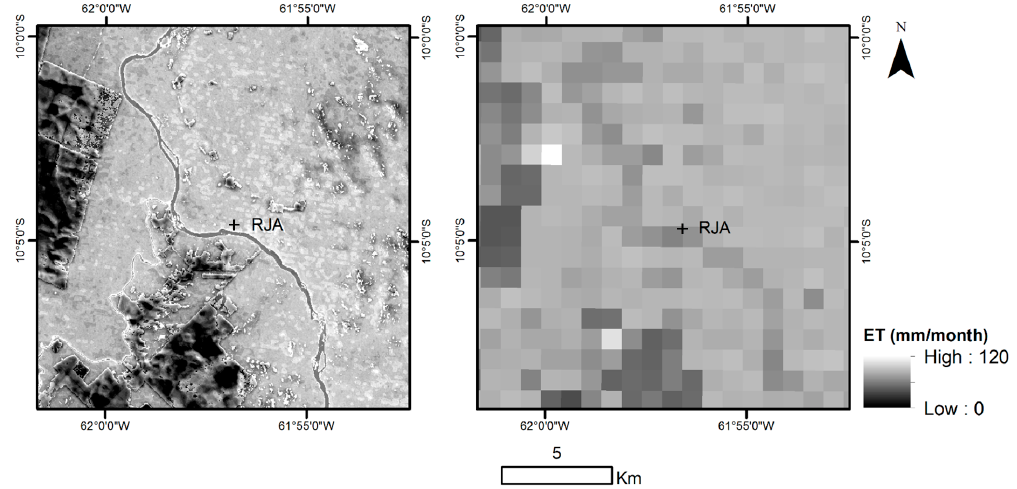
Figure 9. Thirty meter monthly ET map from Landsat using METRIC ( left ) and 1km monthly ET map derived from MODIS (Mu et al. 2007) ( right ) both from July 2000 over the RJA flux tower region.